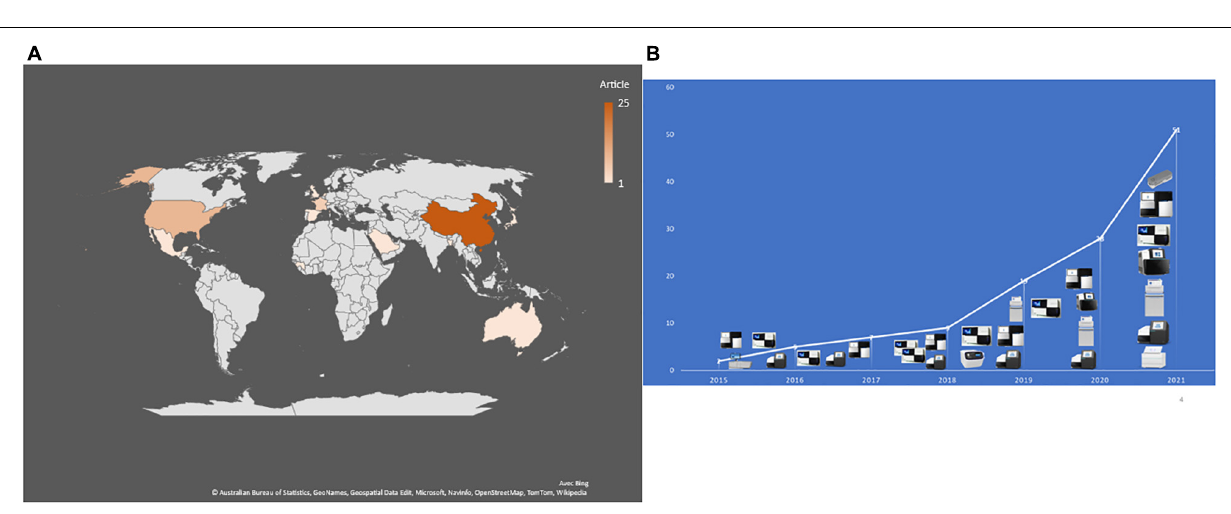
FIGURE 2 | (A) Number and geographical distribution of publication records after duplication removed. (B) Publication chronology according to the used sequencing